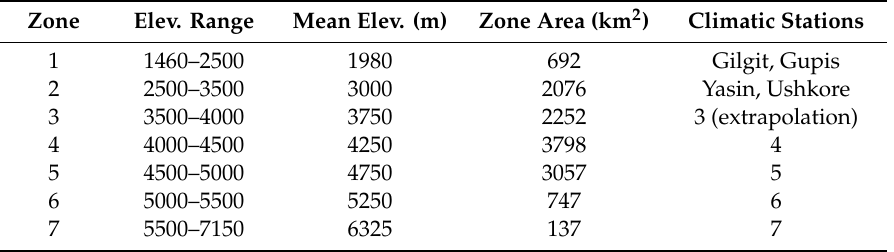
Table 2. Characteristics of 7 altitudinal zones of Gilgit River Basin